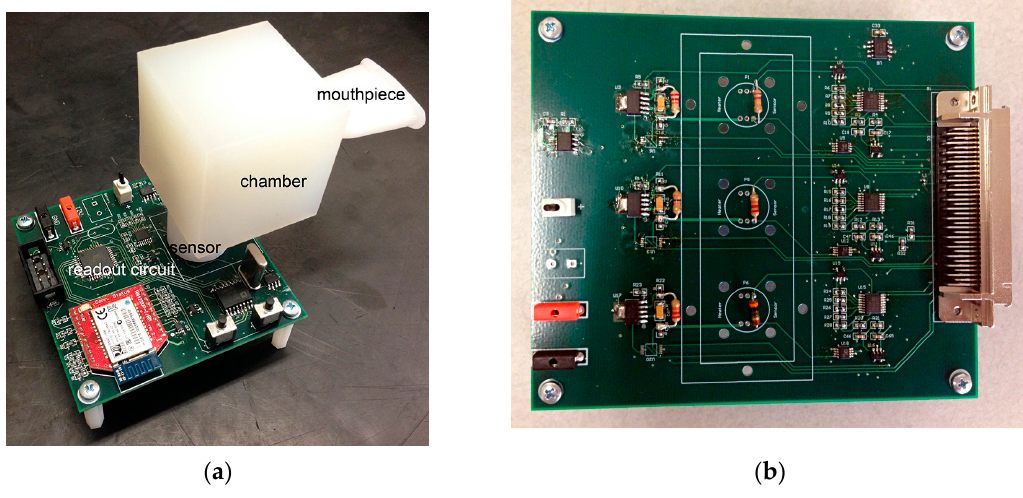
Figure 3. ( a ) A single sensor readout circuit with Bluetooth module; ( b ) A three-sensor system with integrated readout and heater control circuit as a step toward wireless handheld multi-sensor breathalyzer.